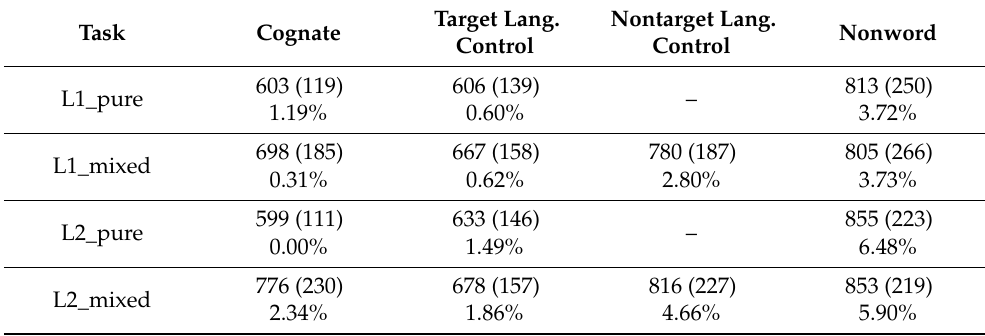
Table 2. Mean reaction times (ms) with standard deviations (ms) and error rates (%) for item categories in the four tasks.